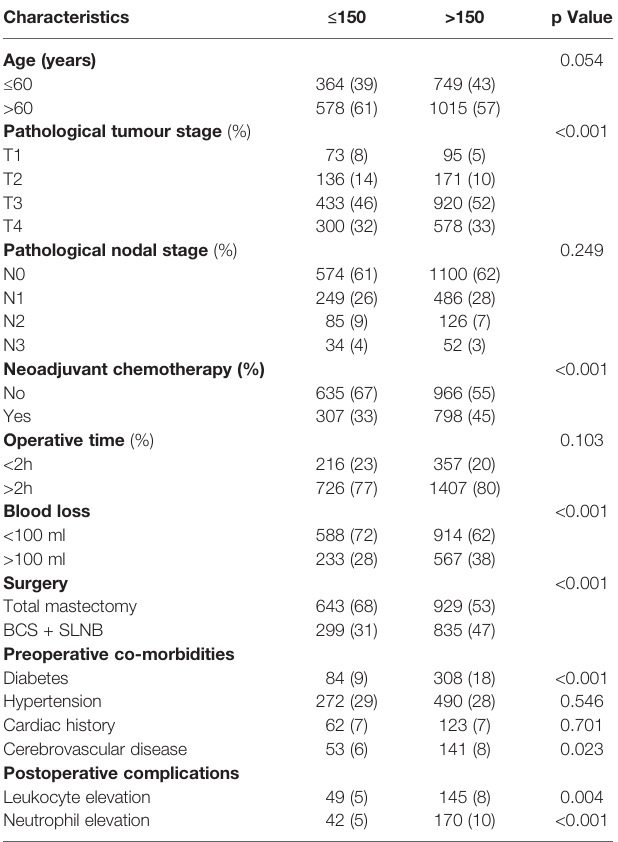
TABLE 2 | Spearman correlation analysis between clinicopathological features and D-dimer.